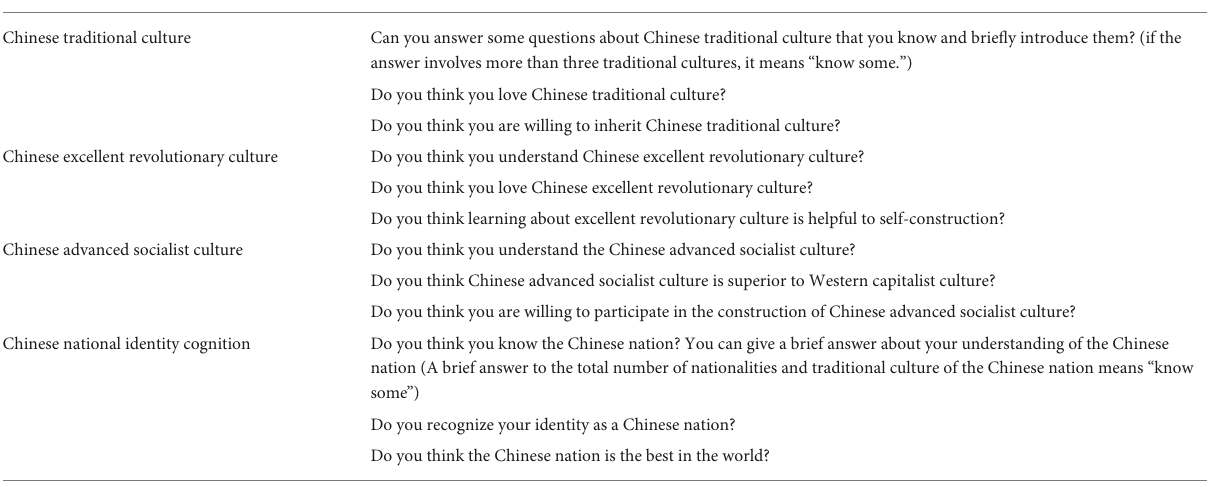
TABLE 3 Differences in the national cognition and cultural acceptance of college students of different genders.